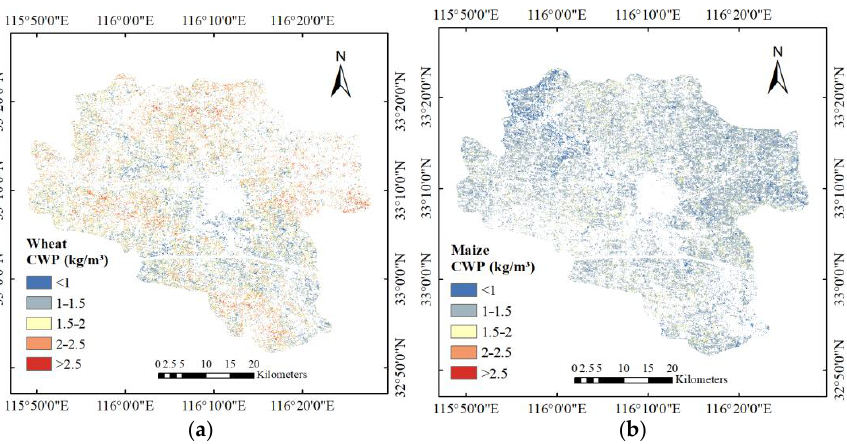
Figure 12. Crop water productivity. ( a ) Winter wheat; ( b ) Summer maize.